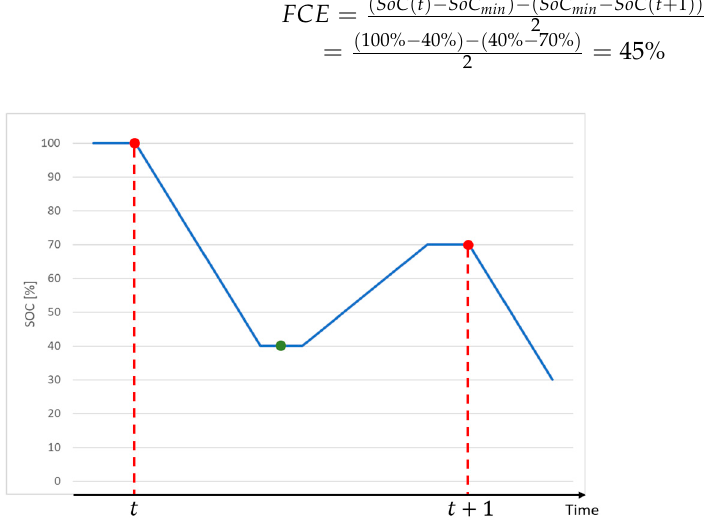
Figure 7. Example for the calculation of the full cycle equivalent (FCE) for the lithium-ion battery lifetime prediction.